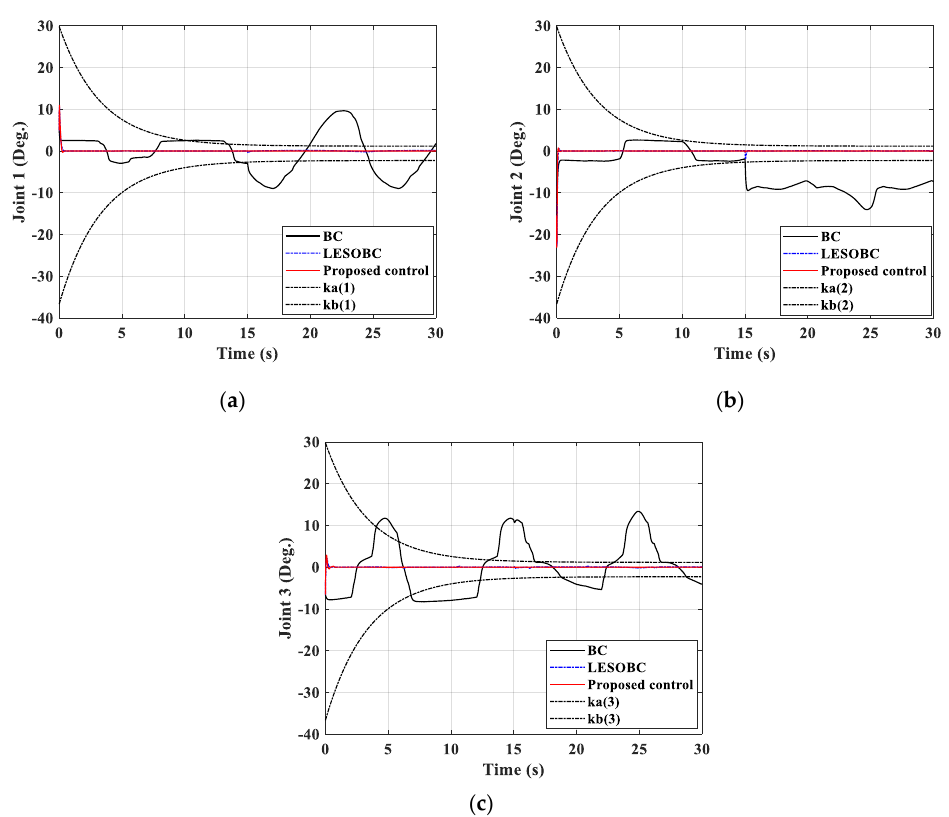
Figure 5. Output responses of the three controllers in ( a ) joint 1; ( b ) joint 2; and ( c ) joint 3 at 0.1 Hz.